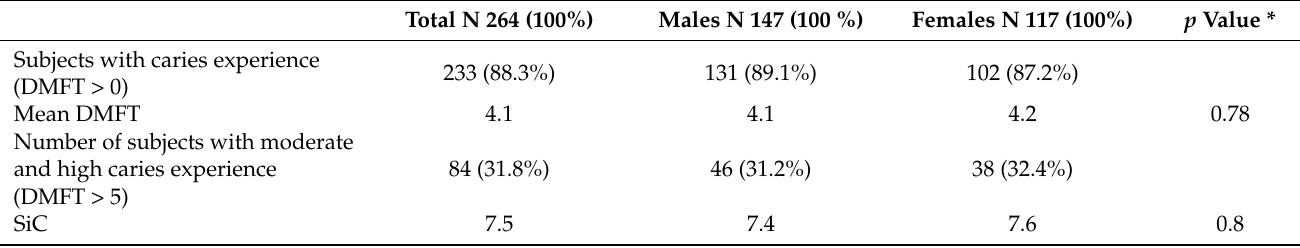
Table 2. Caries experience (DMFT, SiC) among 15-year-old teenagers in